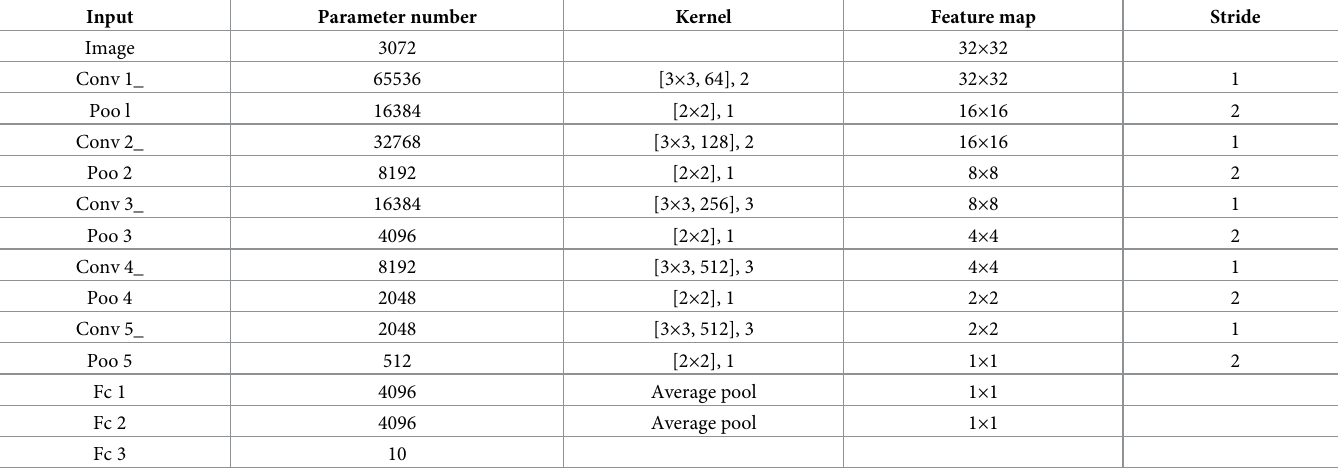
Table 2. Parameter settings.